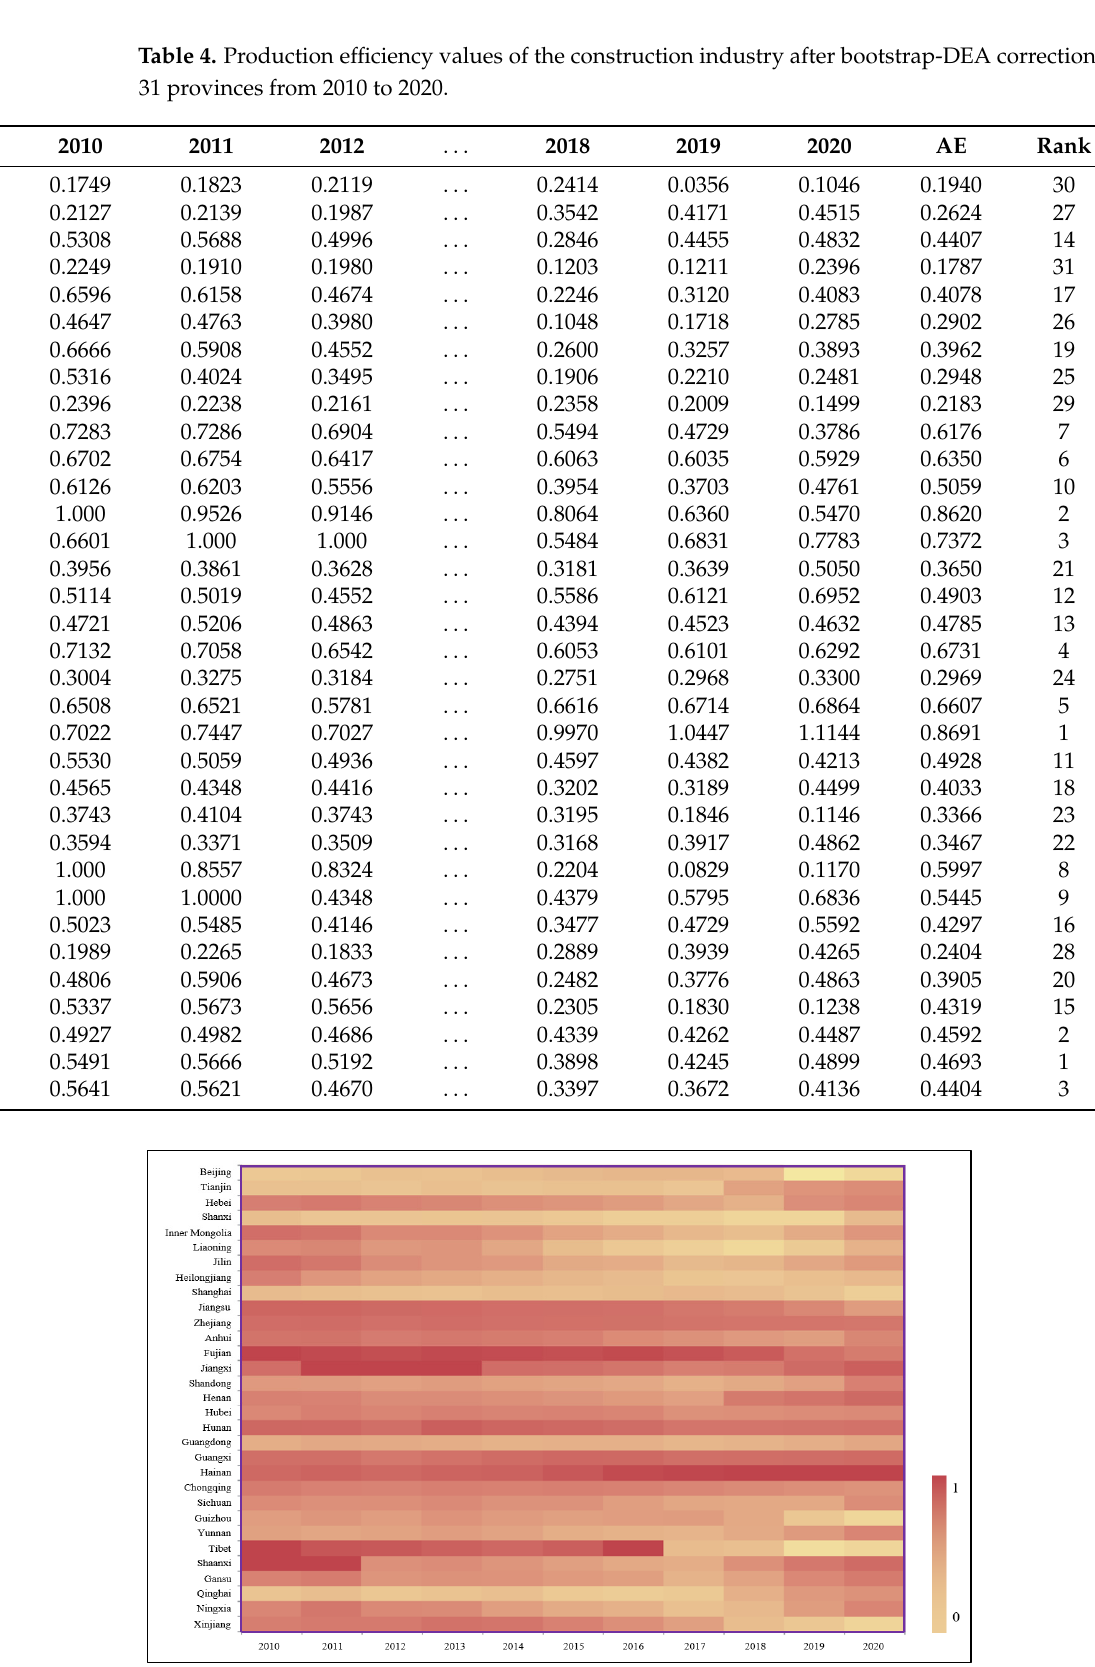
Figure 3. Heat map of the static production efficiencies of the construction industry in 31 provinces in China.